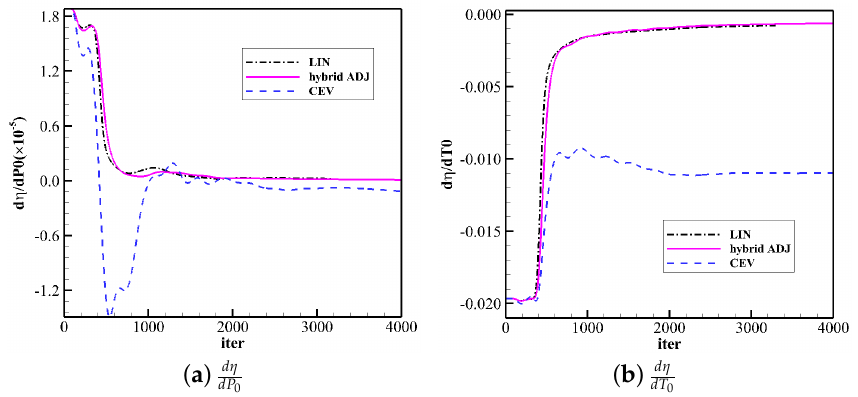
Figure 13. Comparison of sensitivity convergence histories among LIN, CEV, and hybrid ADJ for the NASA Stage 35.